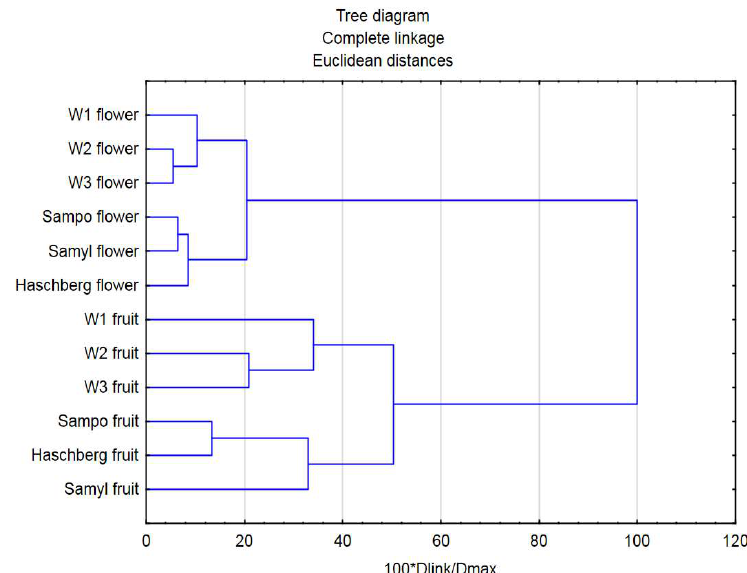
Figure 4. Dendrograms generated after the cluster analysis of elderberry flowers and fruit based on the content of minerals and bioactive